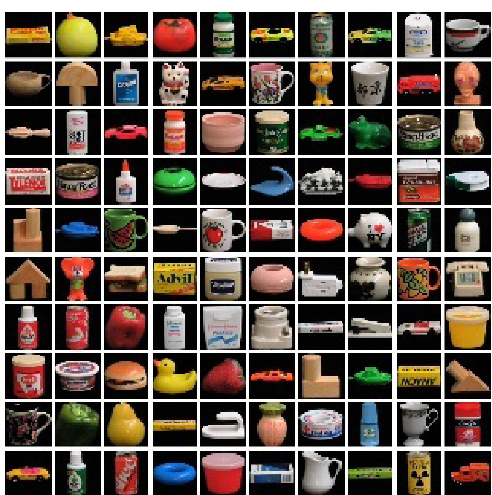
Figure 1. The Columbia Object Image Library